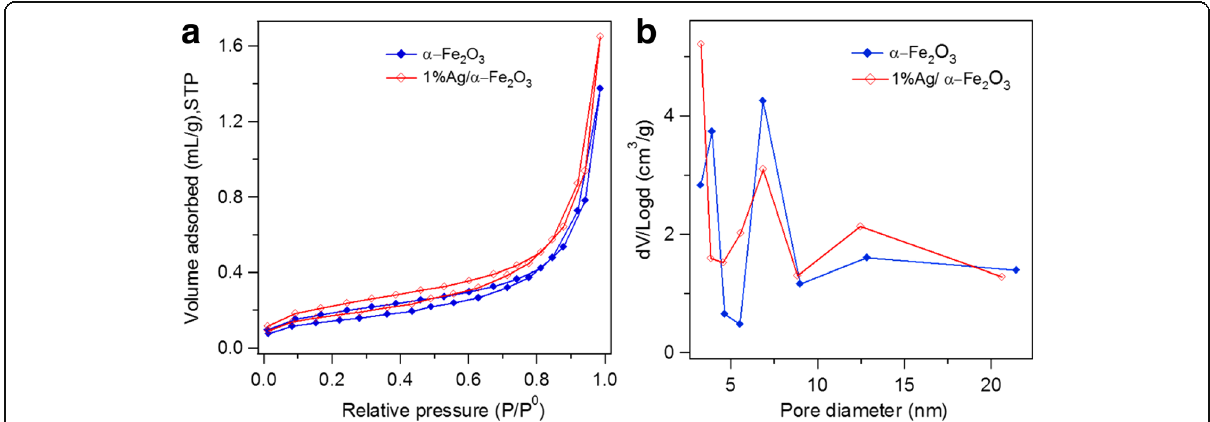
Fig. 6 a N 2 sorption isotherms and b BJH pore size distribution plots of α − Fe 2 O 3 and 1%Ag/ α − Fe 2 O